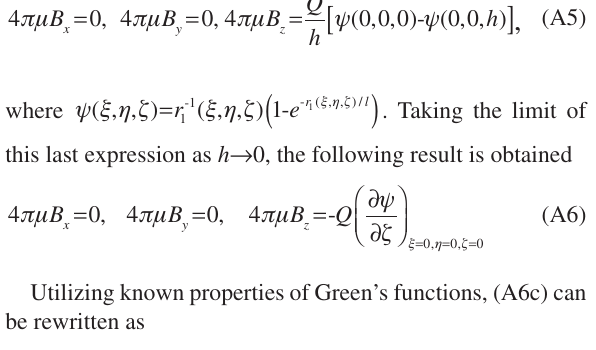
for Al with respect y